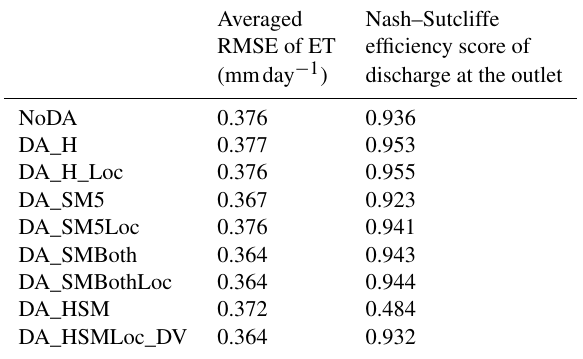
Table 3. Impact of assimilation on evapotranspiration (ET) (aver- aged RMSE with respect to the true model of actual evapotranspi- ration over all 35 soil moisture observation locations during the DA period) and discharge (Nash–Sutcliffe efficiency of discharge at the catchment outlet during the DA period) for each experiment in the Karup